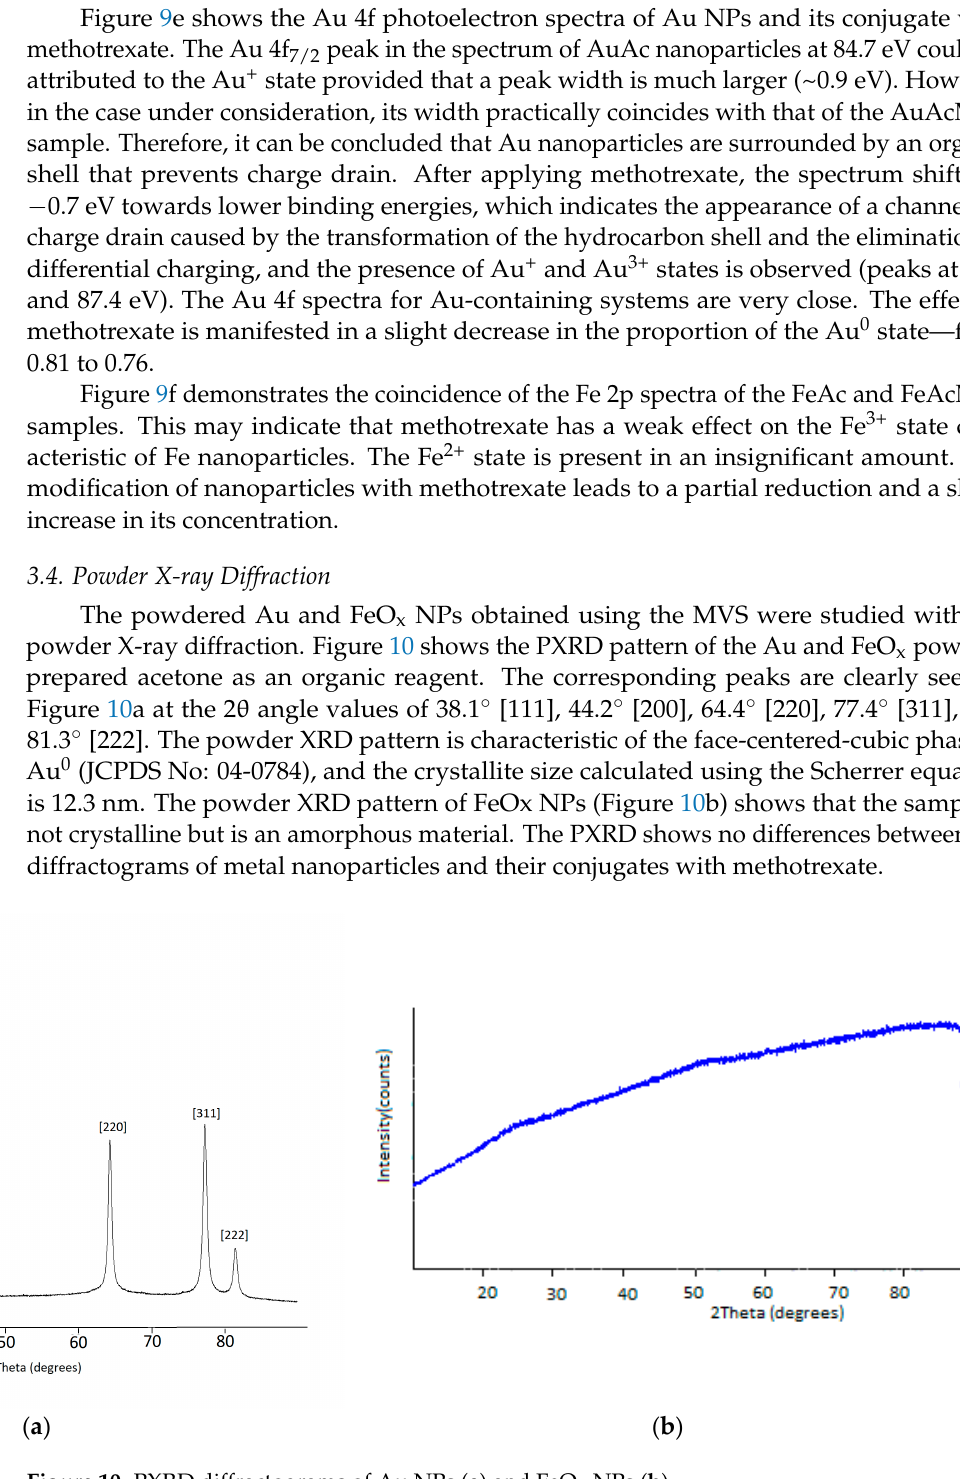
Figure 11. SAXS patterns from the iron and gold nanoparticles obtained in an acetone medium and their conjugates with methotrexate: ( a ) experimental SAXS curves from AuAc (1) and AuAcMTX (2)